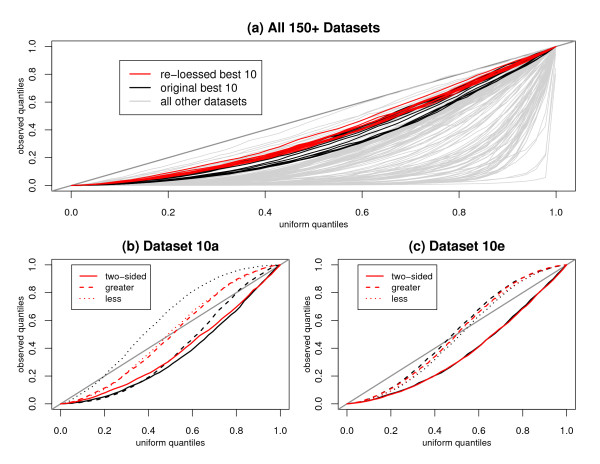
Sample quantile plots for various sets of null p- values. The x-axes correspond to the expected quantiles for a uniform distribution and the y-axes correspond to the observed (sample) quantiles. (a) Sample quantile plots for the t-test p-values associated with the 152 preprocessing combinations described by [1]. Black lines correspond to the 10 best datasets and are consistent with the curves presented in Figure 1 of [2]. The red lines correspond to re-loessed datasets that were obtained using the same combinations of preprocessing steps as the original 10 sets with the exception that the invariant subsets consisted only of the "present null" (present with fold change = 1) probesets (versus both the "present null" and "empty null" probesets used in [1]). The distribution of the p-values thus depends upon the choice of the invariant subset. (b) Sample quantile curves for dataset 10a. Solid lines correspond to the two-sided p-values and the dashed and dotted lines correspond to the p-values associated with the one sided tests. The model presented in [2] does not account for the discrepancy in the one-sided p-values observed for this dataset, which is not manifest in the re-loessed data (red lines). Similar results are seen with datasets 10b, c, d and 9a, b, c, d. (c) As in (b) but showing sample quantile curves for dataset 10e; dataset 9e is similar. The p-value discrepancies are much less pronounced for these two datasets. This figure appears with permission in the response to [2].